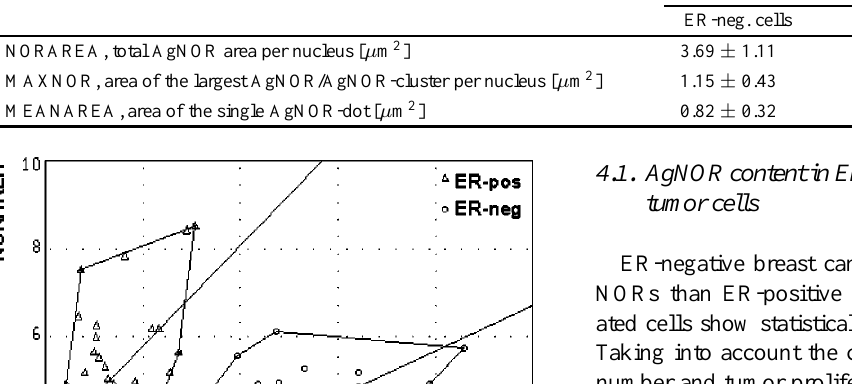
Parameters describing AgNOR area: mean (M), standard deviation (SD) and level of significance p ( t -test) Mean and standard deviation (M (cid:6) SD)